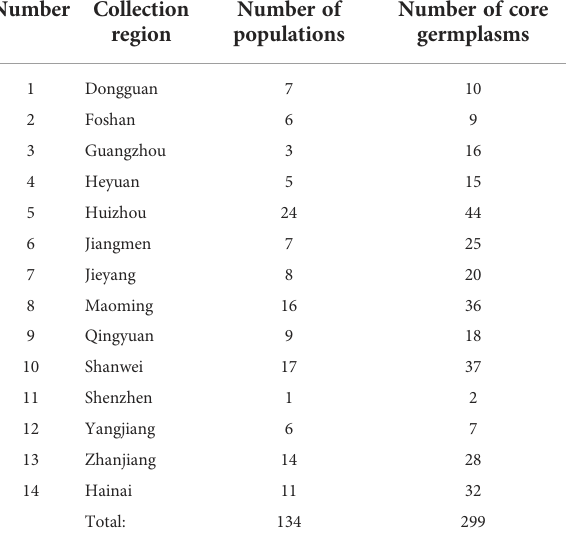
TABLE 2 The origins of core germplasms of O. ru fi pogon in Guangdong.